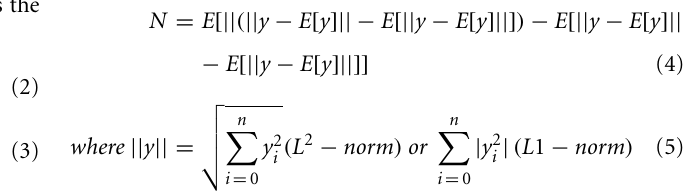
FIGURE 4 | Neural architecture relying on self-assessment. Left: network used to detect unexpected events. It learns the sensory-motor contingency of a given strategy by learning to predict the current sensation from the previous perception. Perception is defined as a short-term-memory of recent sensation/action tuples. Such a perception is used to predict an approximation of the error, variance and skewness relative to the sensation y . A global novelty level gives to the system a direct feedback on the quality of